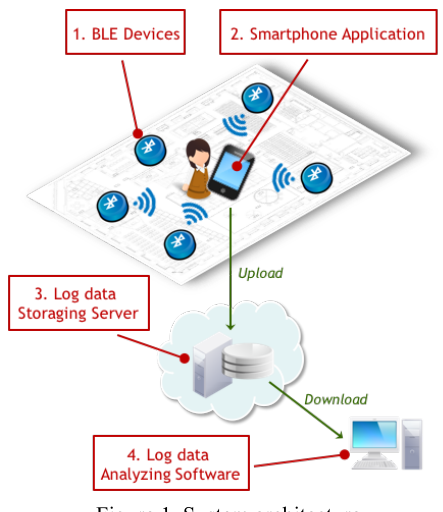
Figure 1. System architecture